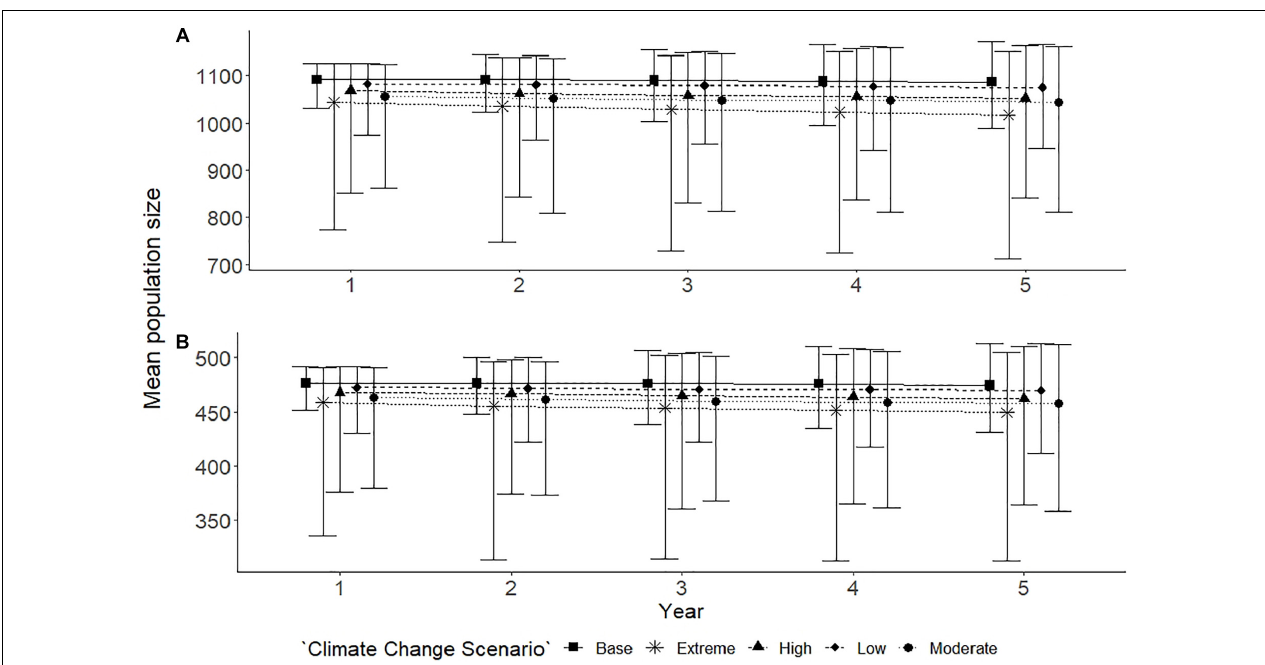
FIGURE 5 | Population trends for Spencer Gulf (A) and Gulf St Vincent (B) under climate change scenarios, predicted over a 5 year period. Five scenarios were examined for each population: base with no disturbances ( (cid:4) ); extreme climate scenario ( ∗ ); high climate scenario ( (cid:78) ); moderate climate scenario ( climate scenario ( (cid:7) ). Scenarios had varying probabilities of occurrence based upon historic climate events and resulted in a proportional reduction in food increasing with severity. Points indicate the mean and error bars indicate standard deviation of the simulations.